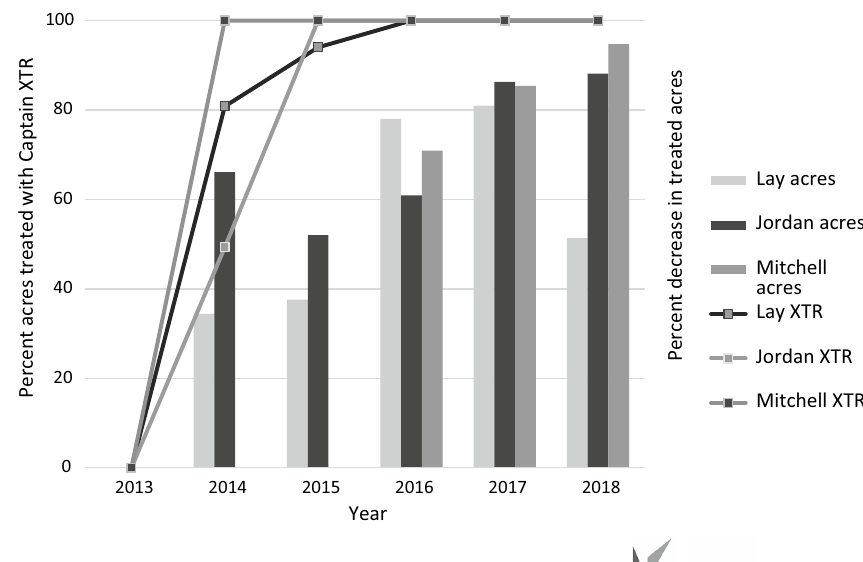
Fig. 6 Percent acres treated with Captain XTR (primary y -axis; lines) compared with percent decrease in total treated acres of L. wollei (secondary y -axis; bars) in three Alabama reservoirs through